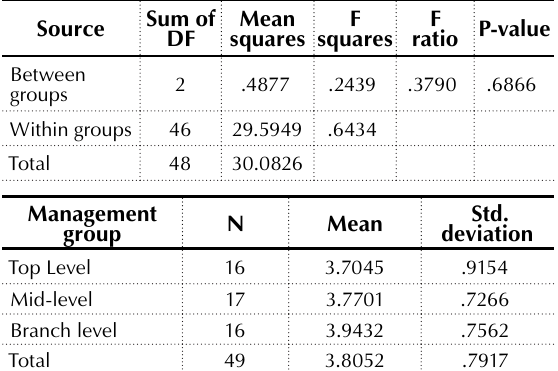
Table 3. Analysis of variance for mean differences